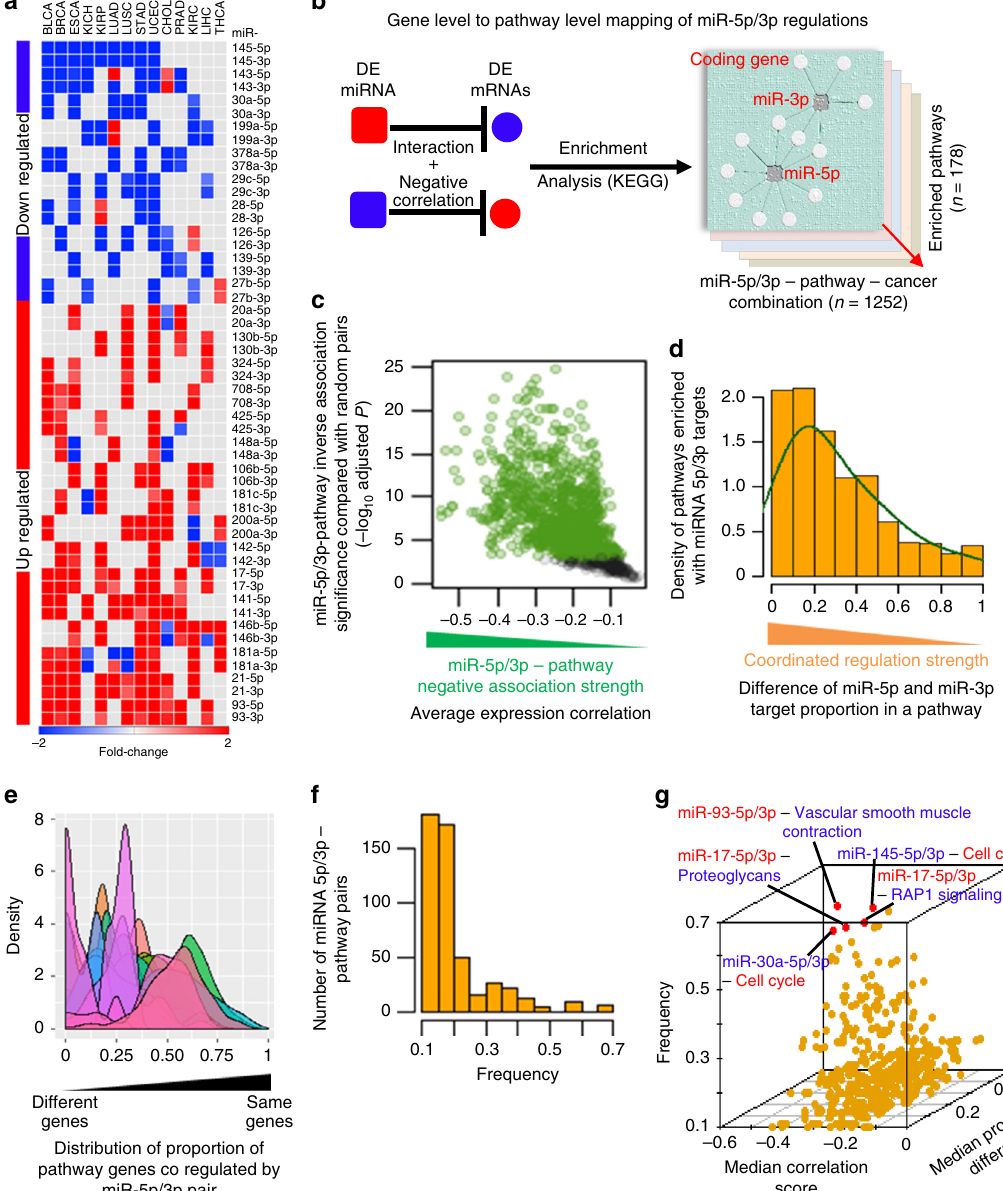
Fig. 2 Identifying pan-cancer dysregulated miRNA 5p/3p pairs and their recurrent associations with oncogenic pathways across cancer types. a Heat map represents pan-cancer dysregulated 5p/3p pairs. Cancer types with red or blue color represent signi fi cant up- or downregulation, respectively, of the indicated mature miRNA. b Overview of approach used to identify miRNA 5p/3p regulated KEGG pathways in cancer. c , d Determining high-con fi dence 5p/3p pair – pathway associations based on whether c they had strong (green dots) inverse associations ( x -axis) or not (black dots) comparing with the random pairs ( y -axis); each dot represents one miRNA-pathway pair, and d the pathway genes were coordinately regulated by the 5p/3p pair. e Determining which 5p/3p pairs coordinately regulate pathways with a trend of co-targeting the same genes ( x -axis, toward 1) or different genes ( x -axis, toward 0) in the same pathway. Each density curve represents one 5p/3p pair and its potentially regulated pathways across cancer types. f Determination of pathways that were recurrently regulated by miRNA 5p/3p pairs across the cancer types. x -axis denotes frequency (number of cancer types with 5p/ 3p – pathway association divided by the number of cancer types the regulating 5p/3p pair had concordant dysregulation). g Three-dimensional scatter plot summarizes inversely associated ( x -axis), coordinately regulated ( y -axis) 5p/3p – pathway pairs that recurrently ( z -axis) associated with cancer types where the corresponding regulating 5p/3p pairs had concordant dysregulation. Top fi ve associations are indicated (red dots); red and blue words denotes up- and downregulation in cancer, respectively, compared to normal